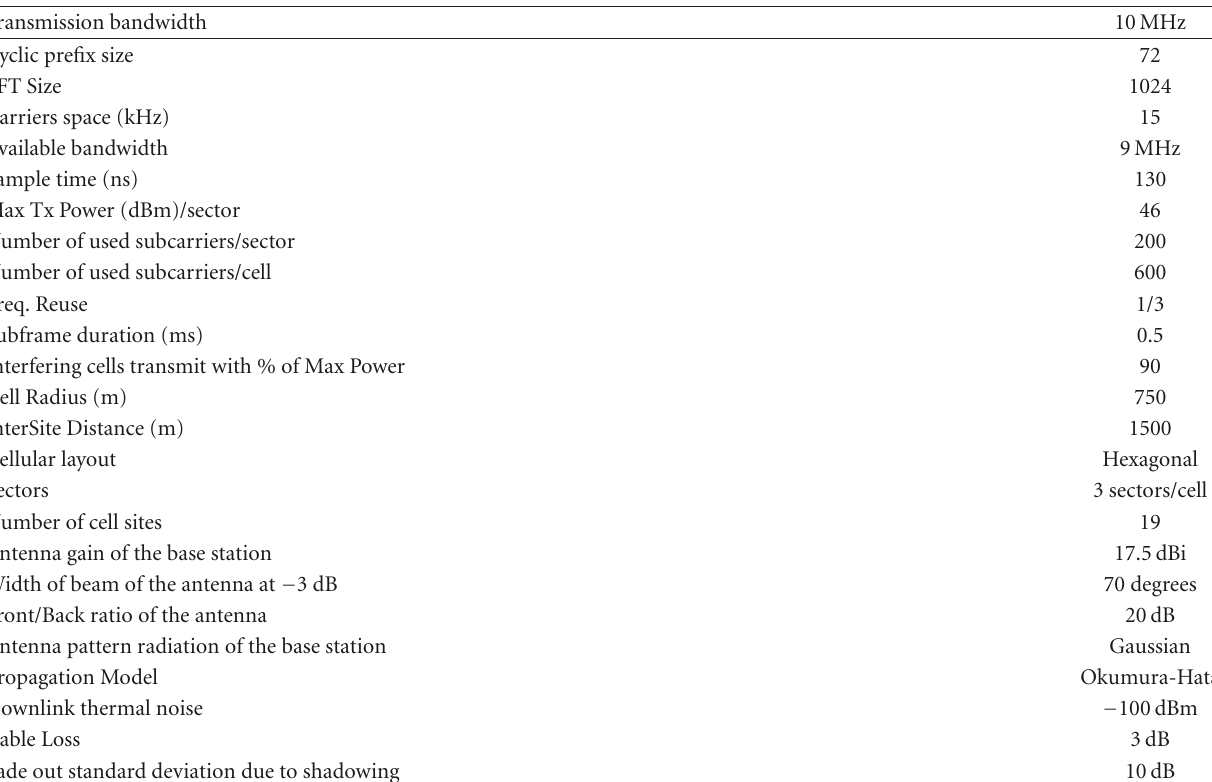
Table 1: Link and system level simulation parameters for urban macrocellular scenario.